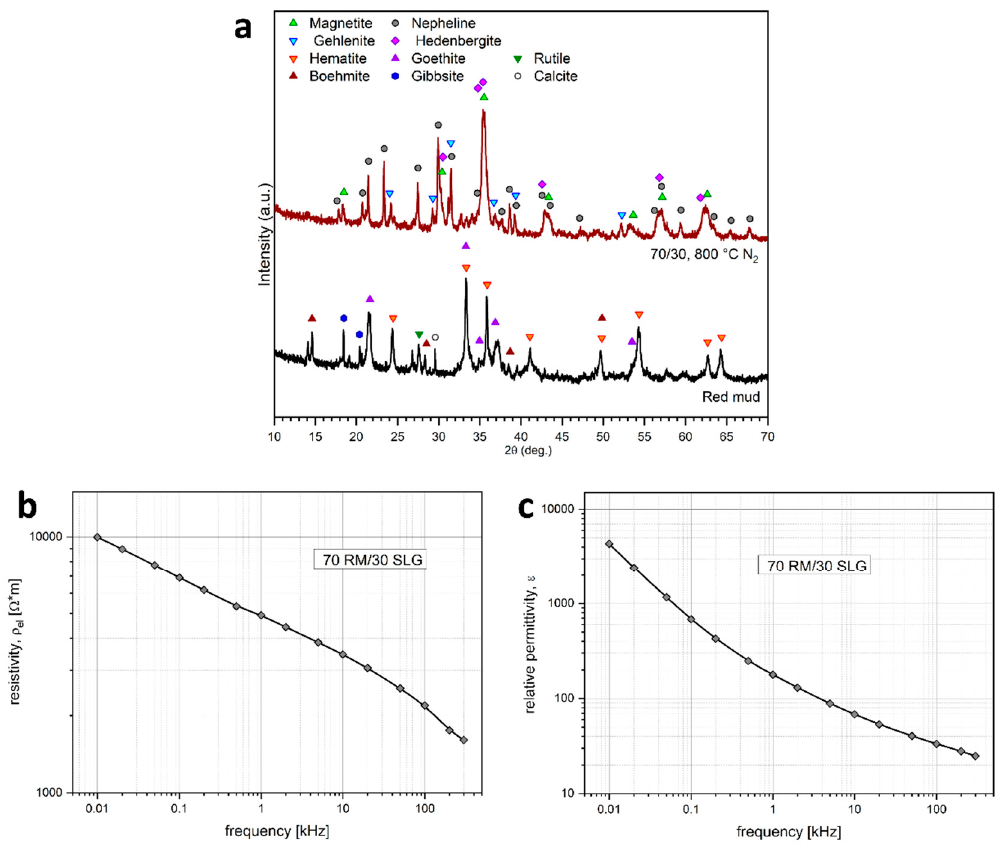
Figure 9. Characterization of RM-derived glass-ceramic foam ( a ) mineralogical analysis; ( b ) resistivity/frequency plot; ( c ) relative permittivity/frequency plot.